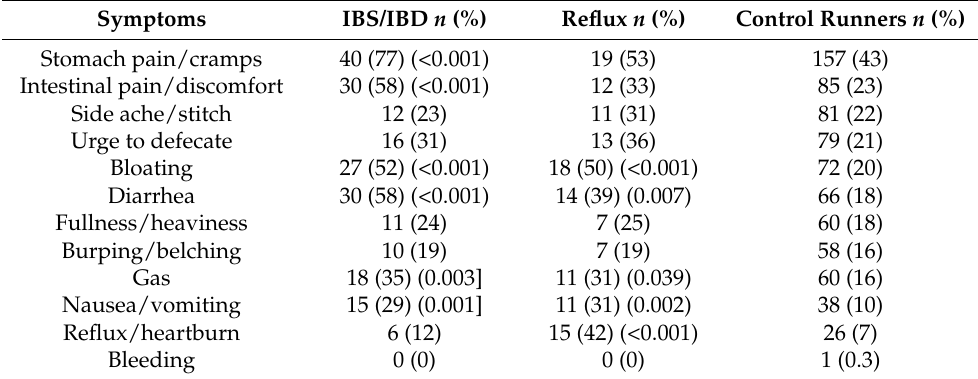
Table 4. Symptoms Experienced if Consumed an Offending Food